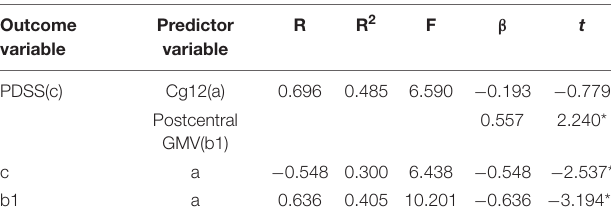
of the left PHG, left SMG, left STG, right SPG, and